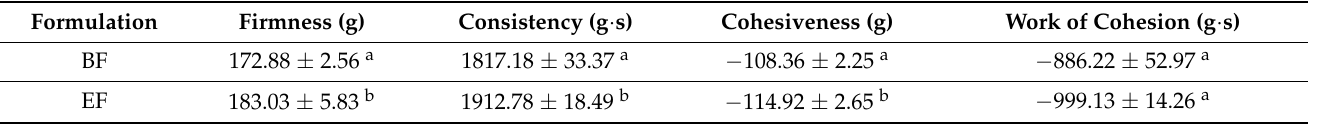
Table 4. Textural evaluation of firmness (g), consistency (g · s), cohesiveness (g), and work of cohesion (g · s) for both blank (BF) and extract (EF) formulations.